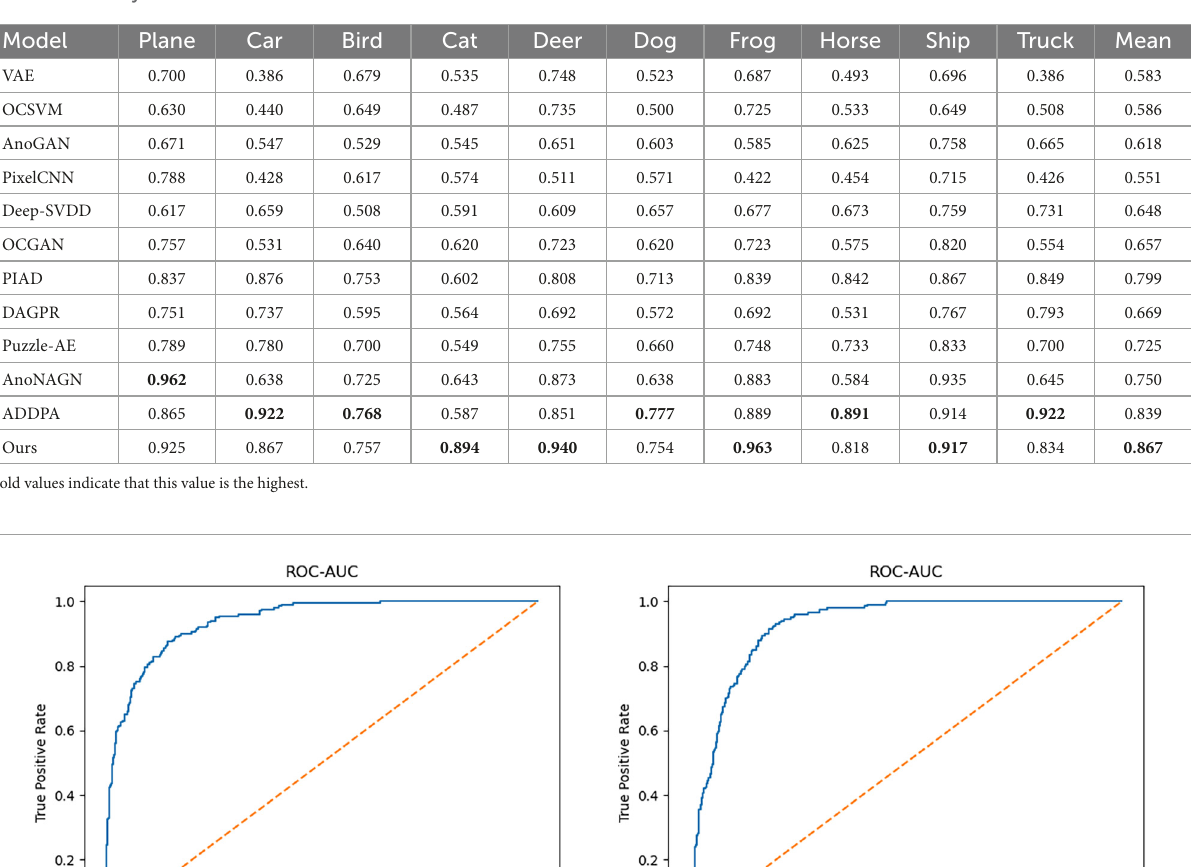
TABLE 3 Anomaly detection results for CIFAR-10 dataset.